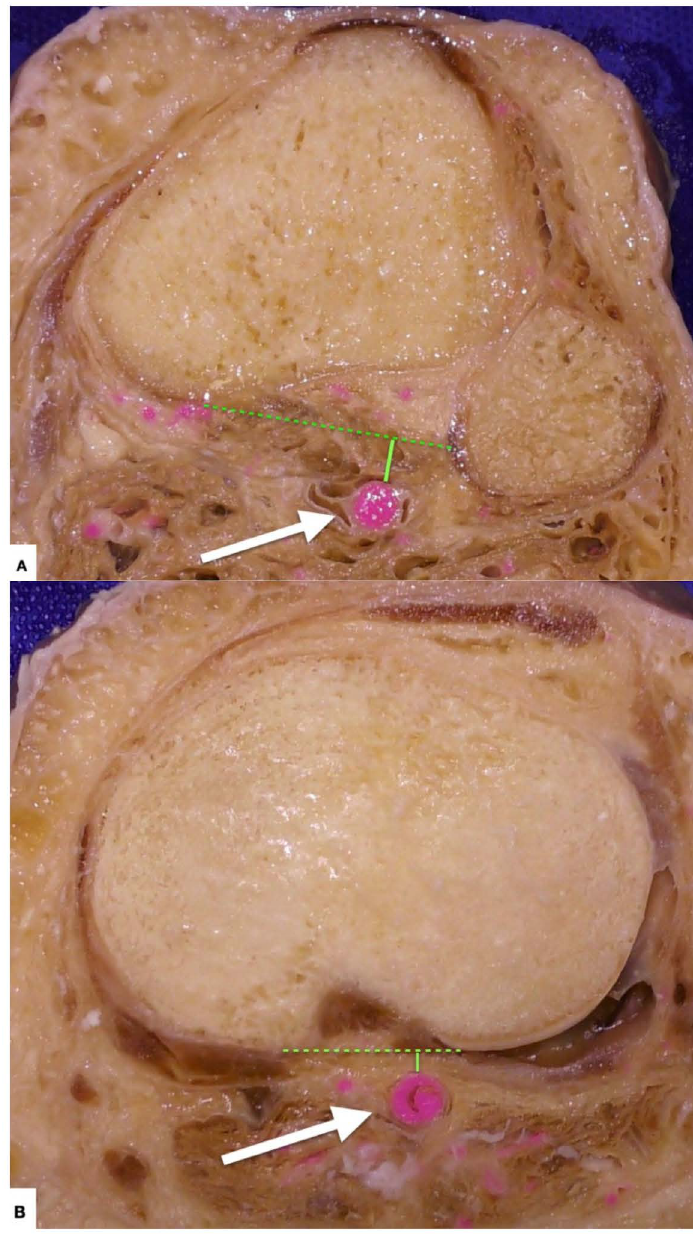
Figure 7. ( A ) Axial view of the tibia at 3 cm below the joint line. Lee et al. found that at the early portion of osteotomy measured at 3 cm below the joint line, the distance (solid green line) between the posterior edge of the proximal tibiofibular joint (green dotted line) and popliteal artery (white arrow) was between 13 and 14 mm [7]. ( B ) Axial view of the tibia just below the tibial plateau. Compared to ( A ), the distance (solid green line) from the tibial artery (white arrow) was shorter (approximately 5 mm) at the end portion of the osteotomy and around the tibia plateau (green dotted line) [7]. The average diameter of the popliteal artery is 8 mm at the subcondylar plane